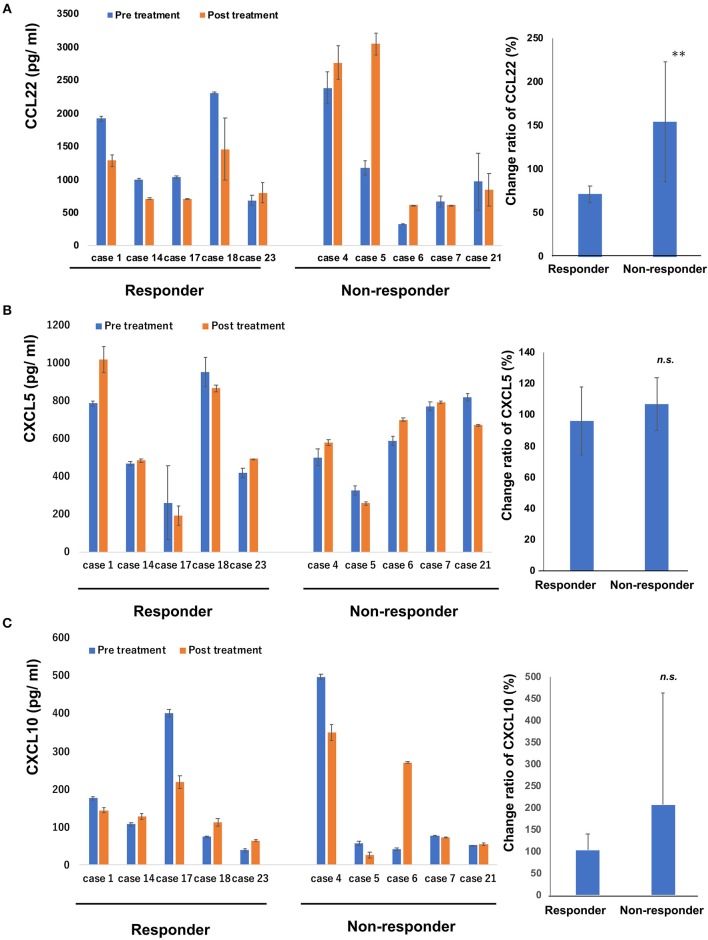
Serum levels of CCL22, CXCL5 and CXCL10 in patients treated with bexarotene. Serum levels of CCL22 (A), CXCL5 (B), and CXCL10 (C) in responders (n = 5) and non-responders (n = 5) at day 0 and day 28 were measured by ELISA. Error bar represents ± standard deviation. Change ratio is calculated described below: (post-treatment serum chemokine)/(pre-treatment serum chemokine level) × 100 (%). Change ratios of serum CCL22 (A), CXCL5 (B), and CXCL10 (C) in CTCL are calculated in each sample and the average are shown. Error bar represents ± standard deviation. **p < 0.01, Mann–Whitney U-test; n.s., not significant.